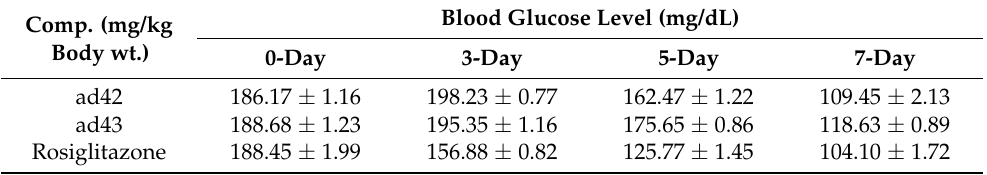
Table 48. Antidiabetic potential of the compounds ( ad42 – ad43 ) in alloxan-induced diabetes in rats.